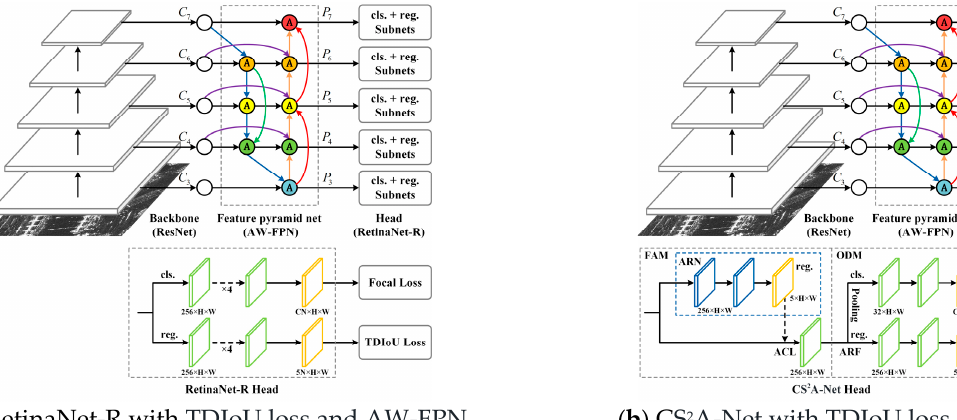
Figure 19. Architectures of two baselines. As a plug-and-play scheme, TDIoU loss and AW-FPN can be easily embedded into the above rotation detectors. ( a ) The regression output of RetinaNet is modified to an OBB under long-edge definition. Here, ‘C’ denotes the number of categories, and ‘N’ denotes the number of anchors on each feature point; ( b ) the CS 2 A-Net head consisting of the FAM and ODM can be cascaded to improve accuracy. The number of cascade heads is set to 2 by default. The CS 2 A-Net is an advanced rotation detector based on the RetinaNet architecture.